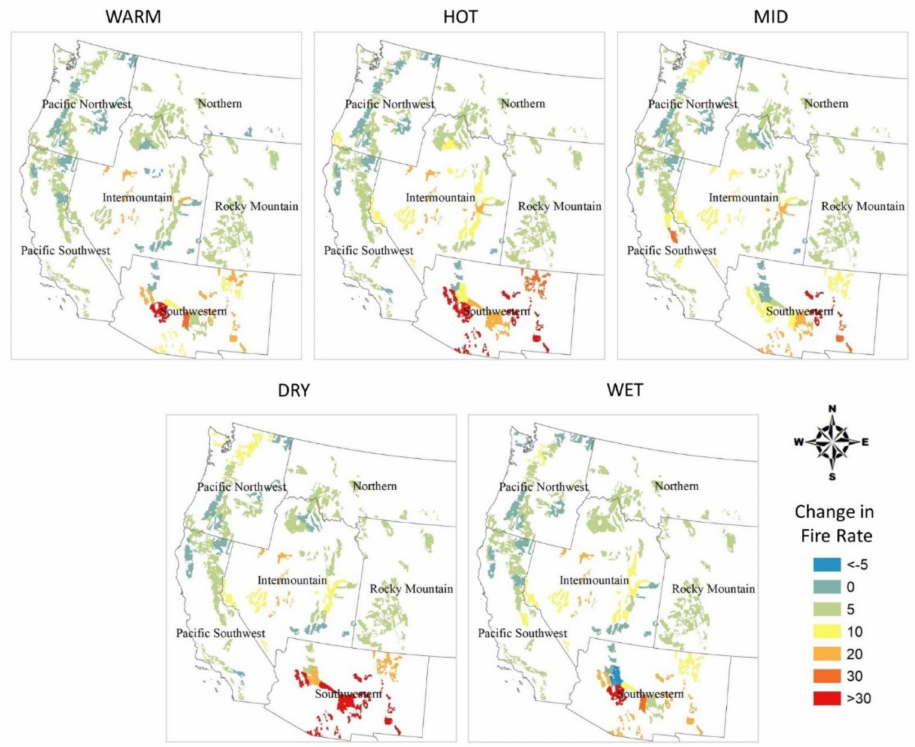
Figure 6. Changes in rate of minor forest fires from historical (1986–2015) to future conditions (2070–2099) in western U.S.